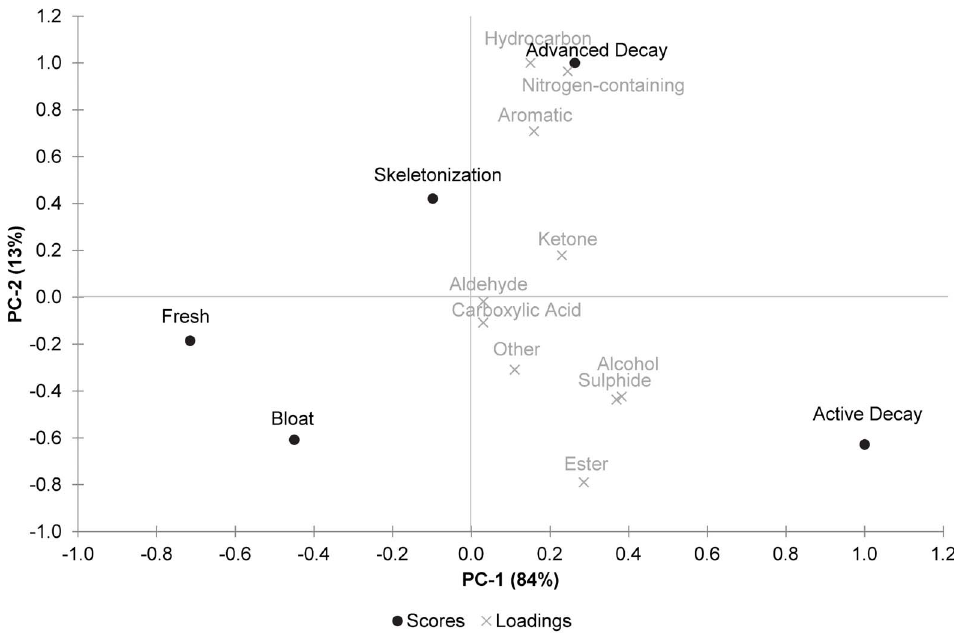
Figure 4. PCA biplot of the calculated scores and loadings for the soil experimental samples.